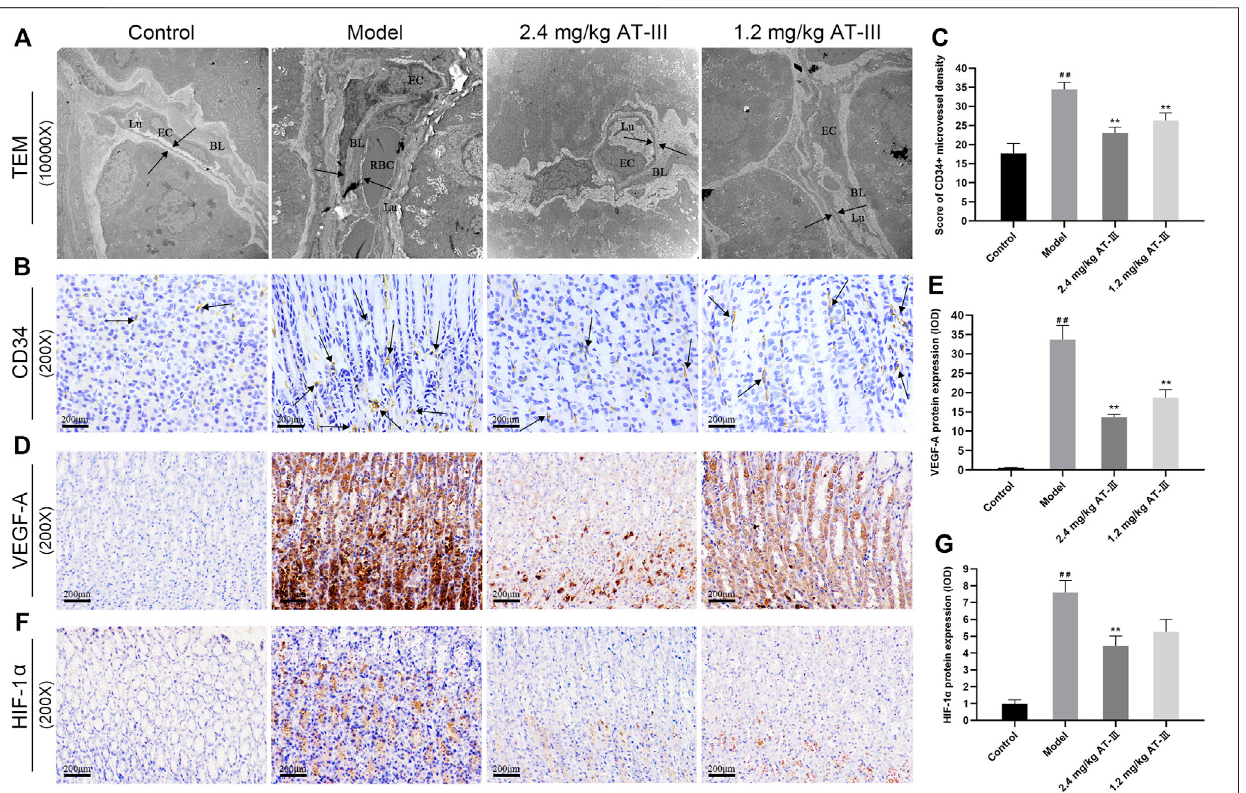
FIGURE 3 | Evaluation of microvessel density in gastric mucosa. (A) Representative images of ultrastructures of epithelial cells using TEM (×10000). (B) CD34-labelled microvesselsingastricmucosaofeachgroup(IHC,×200).ExpressionofVEGF-A (D) andHIF-1 α (F) proteinindifferentgastricmucosa(IHC,×200).EffectofAT-IIIonCD34levels (C) ,VEGF-A (E) andHIF-1 α (G) proteinexpressionsingastricmucosafromvariousgroups( n =10).Dataarepresentedasmean±SEM.RBC,redbloodcell;EC,endothelialcell; BL,basallamina;Lu,lumen. ## p < 0.01versusthecontrolgroup;** p < 0.01versusthemodelgroup.RBC,red bloodcell;EC,endothelialcell;BL,basallamina;Lu,lumen; TEM, transmission electron microscopy; AT-III, Atractylenolide III; IHC, immunohistochemistry; SEM, standard error of mean.